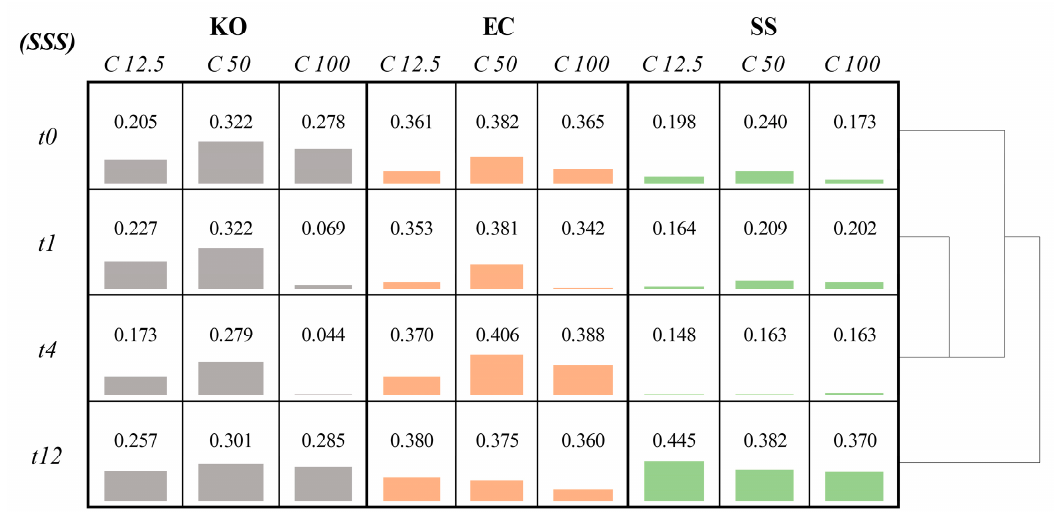
Figure 5. Matrix presenting average values of spectra similarity score (SSS), concerning comparison between unstressed spectrum and assays using silver nanoparticles (AgNPs) at 12.5, 50, and 100 µg mL − 1 , for periods of time 0, 1, 4, and 12 h. Gray, orange, and green bars refer to K. oxytoca (KO), S. saccharolyticus (SS), and E. coli (EC), respectively; C—concentration (µg mL − 1 ); t—time (h). For K. oxytoca , it can be seen that for concentration 100 µg mL − 1 , the biggest changes in profiles were obtained for 1 and 4 h after supplementation with AgNPs. After 12 h, an adaptation to the stressing agent is observable resulting in an increased spectrum similarity score to the original native strain. For lower concentrations (12.5 and 50 µg mL − 1 ), K. oxytoca manifested stronger resistance to